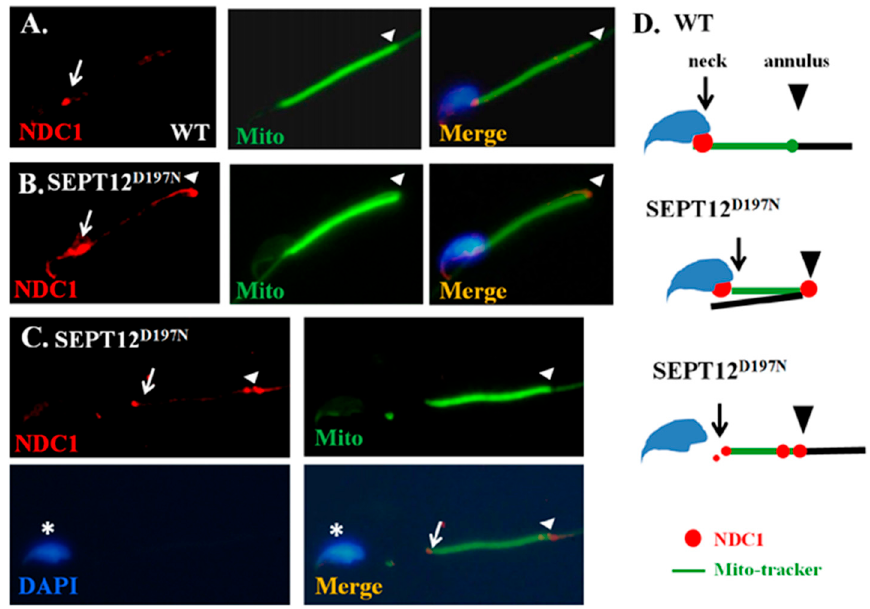
Figure 5. Localization of NDC1 in sperm from SEPT12D197N mice. IFA results showing multiple localizations of NDC1 signals in ( A ) wild-type sperm and ( B , C ) SEPT12D197N sperm. Anti-NDC1 antibody (“NDC1” panels), MitoTracker (“Mito” panels), DAPI (“DAPI” panel), and a combination of the anti-NDC1 antibody and MitoTracker (“Merge” panels) were used as stains. ( A – C ) NDC1: red; Mito: green; DAPI: blue. Arrows = sperm neck; Arrow head = annulus; * = sperm head. Magnification = 1000×; Scale bar = 5 μ m; ( D ) a cartoon model of SEPT12D197N affecting NDC1 location. Blue area: Sperm-head; green-line: mito-tracker; black line: principal piece; arrow: sperm-neck; arrow head: annulus.